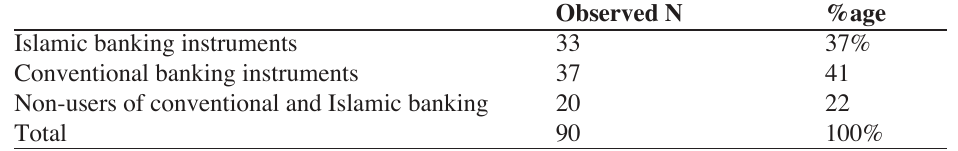
Table 2: SMEs percentage using Islamic banking